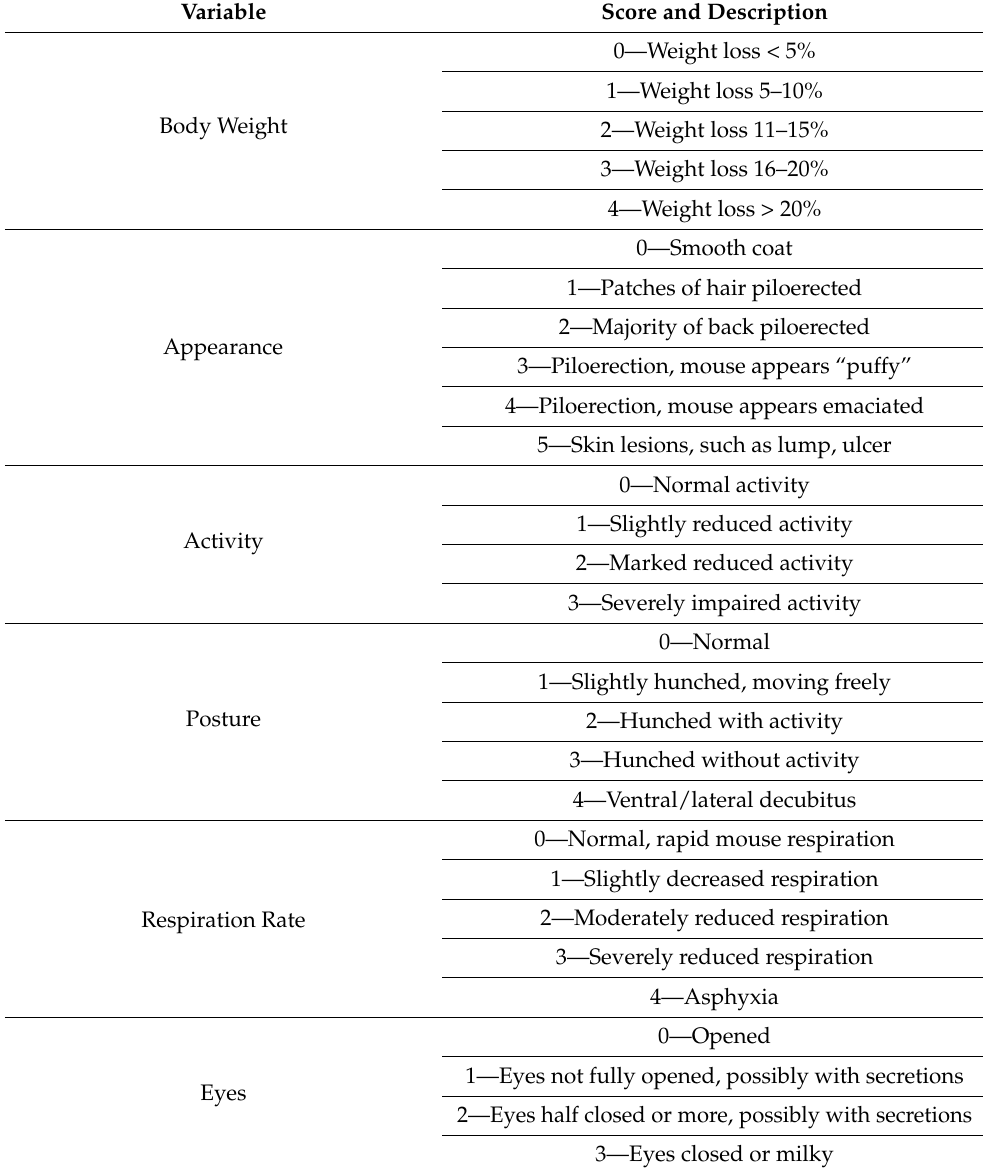
Table 3. Scoring system for mice clinical signs’